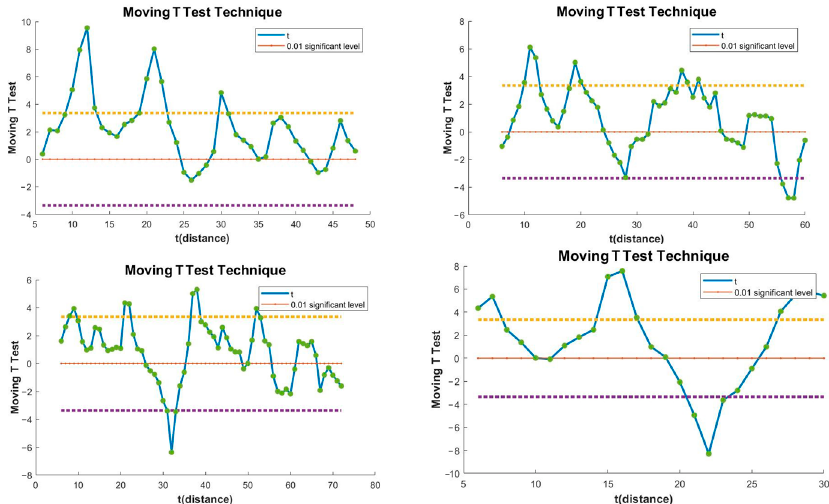
Figure 4. Partial data sequence test results.